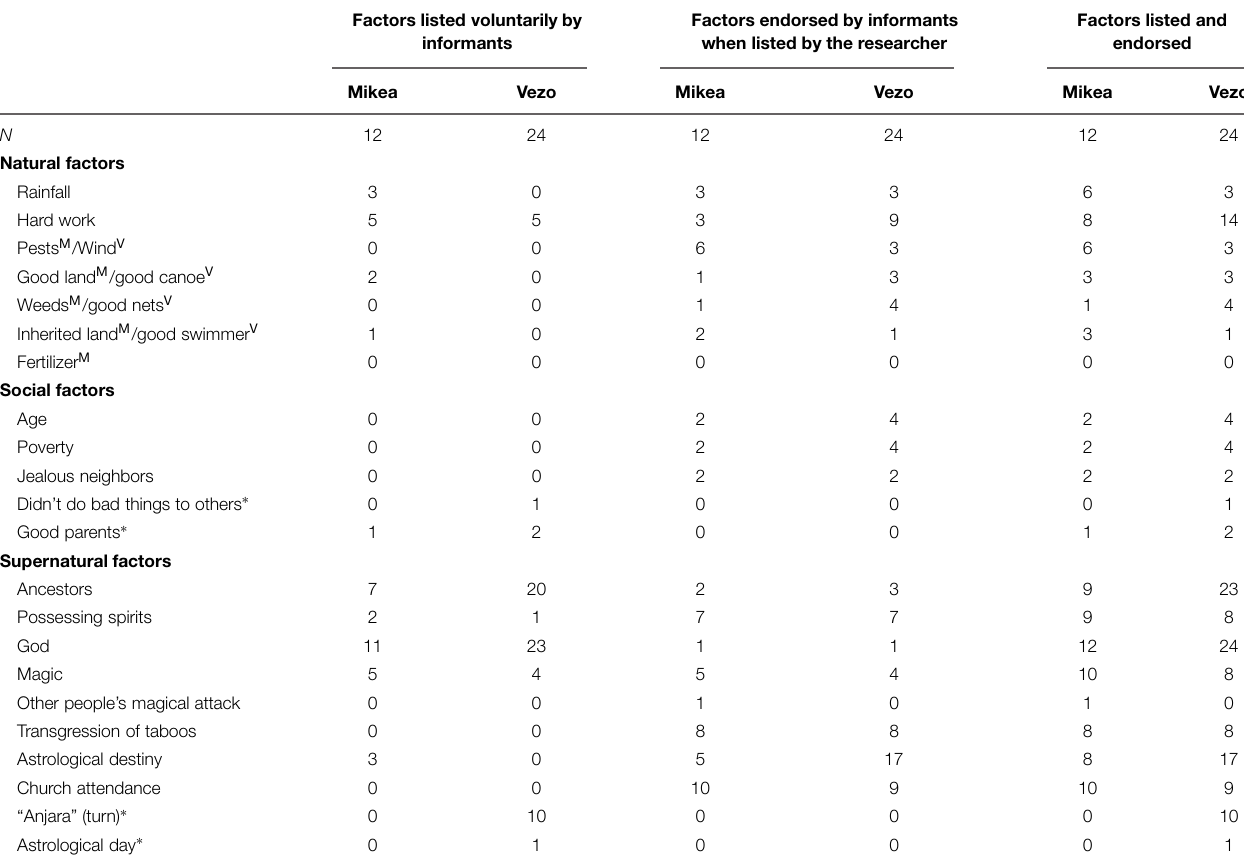
TABLE 4 | Frequency that different natural and supernatural factors were listed or endorsed by Mikea and Vezo informants. Factors listed voluntarily by Factors endorsed by informants informants when listed by the